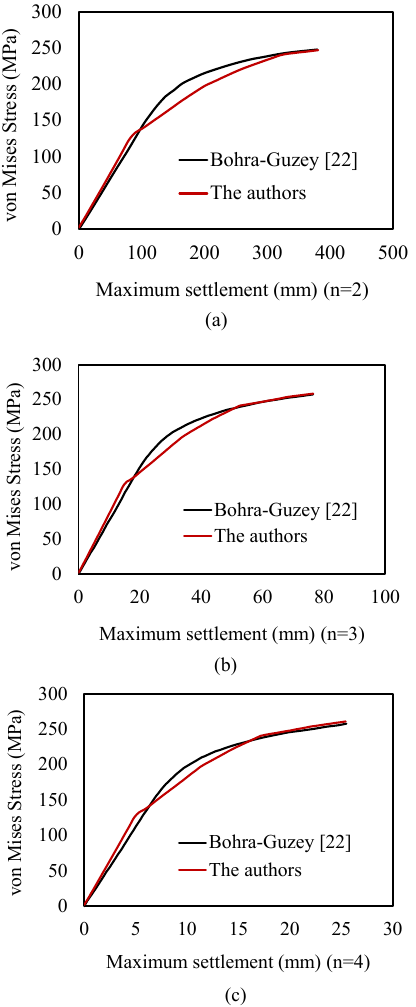
Figure 7. Comparison of results of the tank model TK-300 for settlement vs von Mises membrane stress for different harmonic wave numbers: ( a ) n = 2; ( b ) n = 3; ( c ) n =